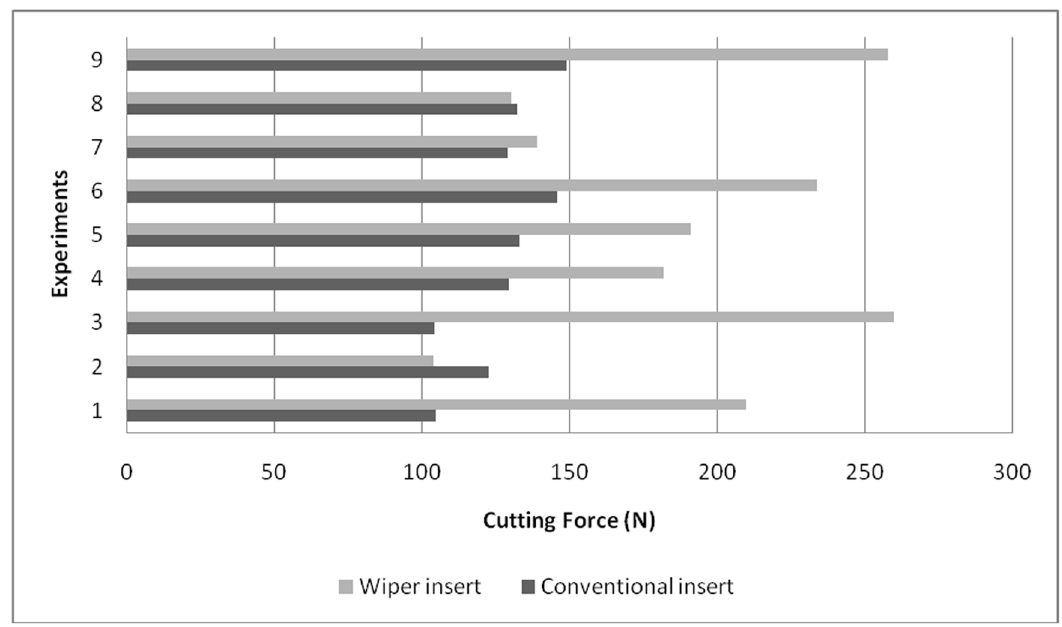
Figure 3: Cutting force